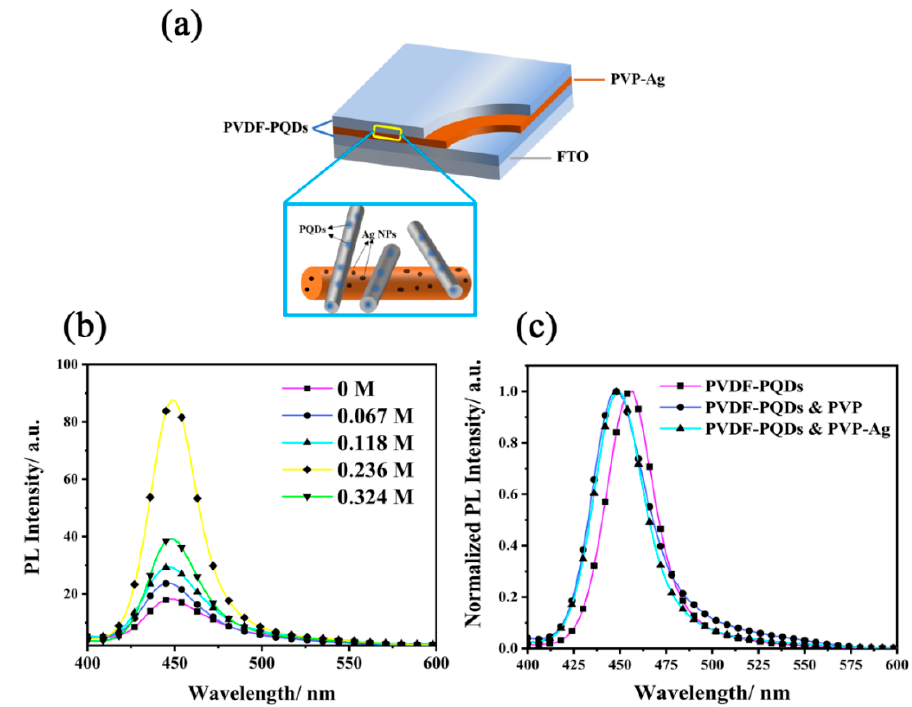
Figure 5. ( a ) The schematic diagram of the multilayer membrane structure. The insert is enlarged view of PVP-Ag and PVDF-PQD nanofibers on the interface between PVP-Ag and PQD layers ( b ) PL spectra of the composite membranes with a layer of PVP-Ag nanofibers sandwiched in the MAPbBr 1.2 Cl 1.8 membranes, and the concentrations of Ag NPs varying from 0 to 0.324 M. ( c ) Normalized PL spectra of PVDF-MAPbBr 1.2 Cl 1.8 membranes, the sandwich structural with a PVP film between the PVDF-MAPbBr 1.2 Cl 1.8 films and the sandwich structural with PVP-Ag nanofiber film between the PVDF-MAPbBr 1.2 Cl 1.8 films.